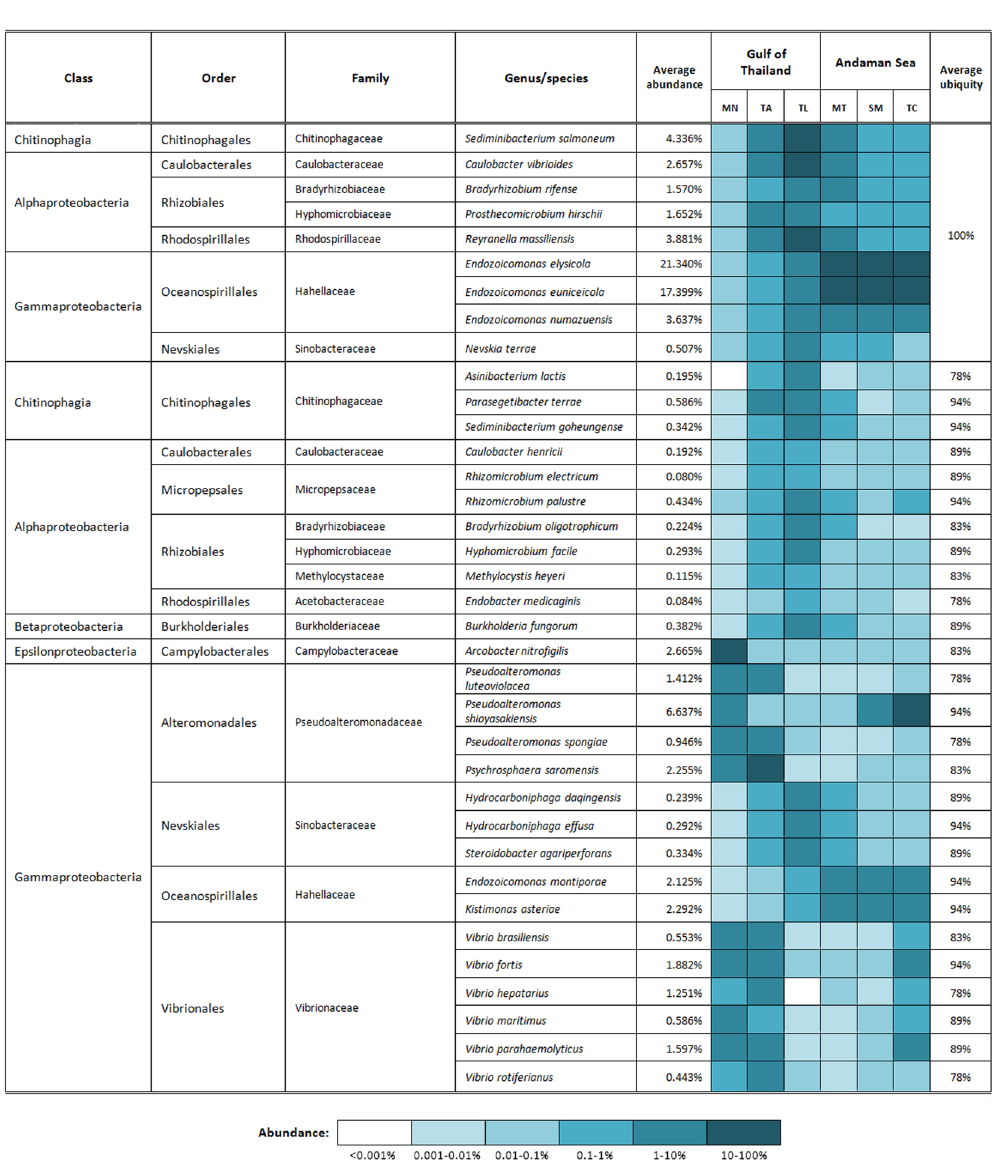
community analysis (Fig. 5). Similarly, in acroporid coral Acropora granulosa , only two (out of 159 phylotypes detected within at least 30% of samples) were found to have higher than 5% relative abundance within their bacterial-associated communities 60 . These findings highlight the need for caution when determining bacterial associates as core members of the microbiome based solely on a high relative abundance within the host’s whole community 60, 69 . Interestingly, while Littman et al . 70 demonstrated that bacterial profiles separated Acropora corals based on geographic locations, their conclusions were based primarily on dominant members of the community driving the differences between locations. Upon careful examination of individual sequences that represented minor components of retrieved 16S sequences, the authors indeed noticed the same bacterial phylotypes within